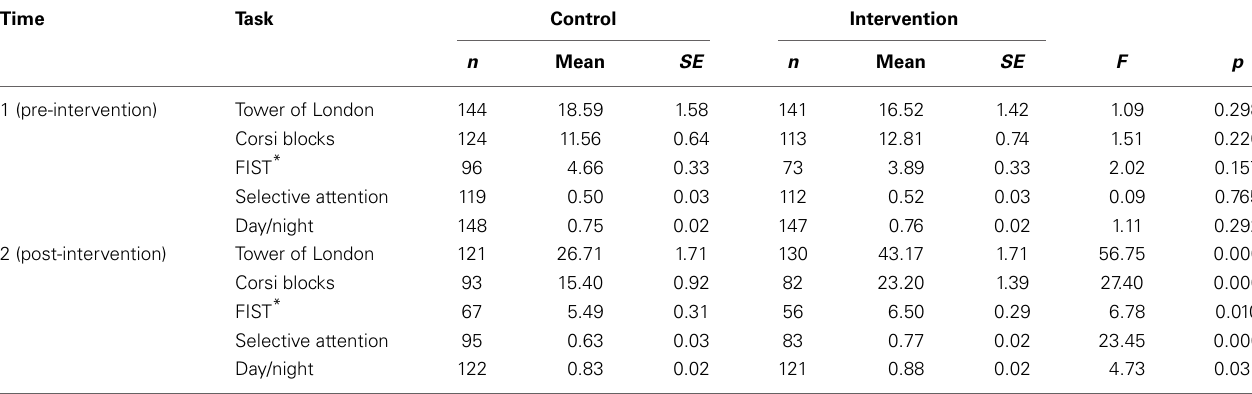
Table 4 | Performance by task, time of assessment, and group in the SIP.